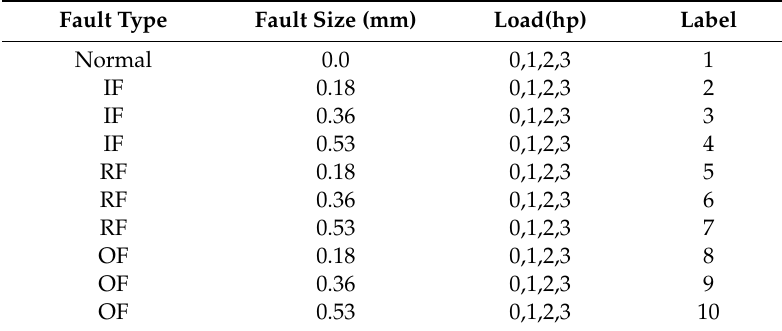
Table 1. Bearing data information used to experiment in this